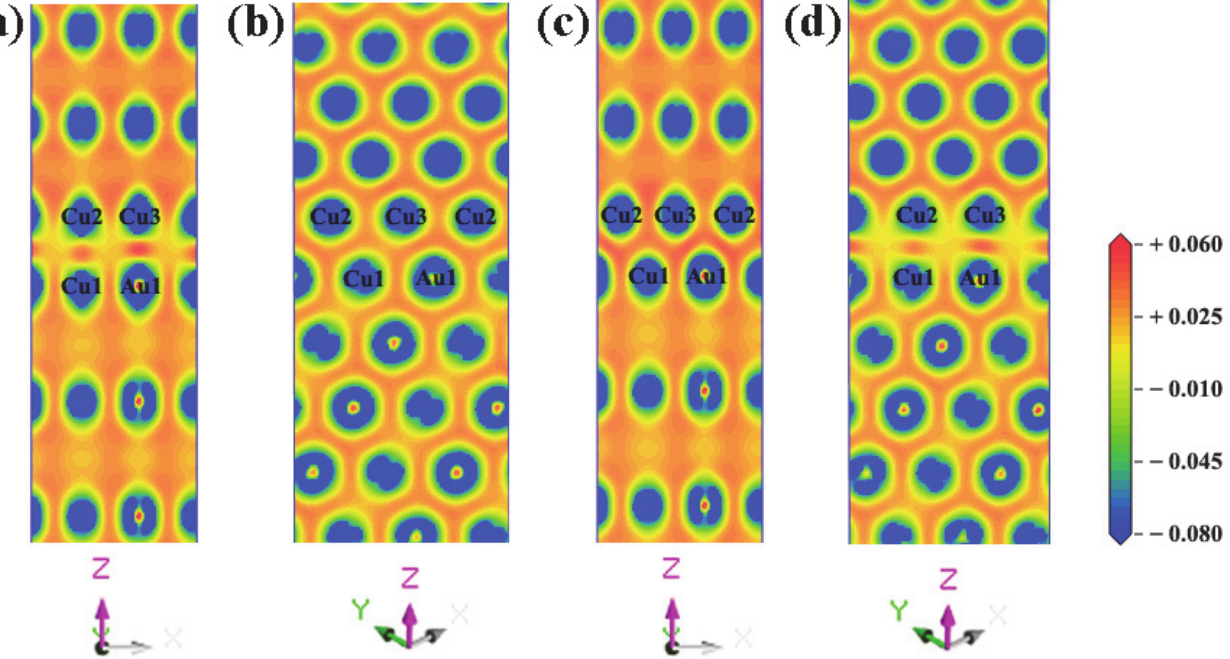
Figure 4. Charge density difference around the interface for four different Cu(200)/AuCu(200) interface models (unit: e/Å 3 ): ( a ) Top site, ( b ) Long bridge, ( c ) Short bridge, and ( d ) Hollow.